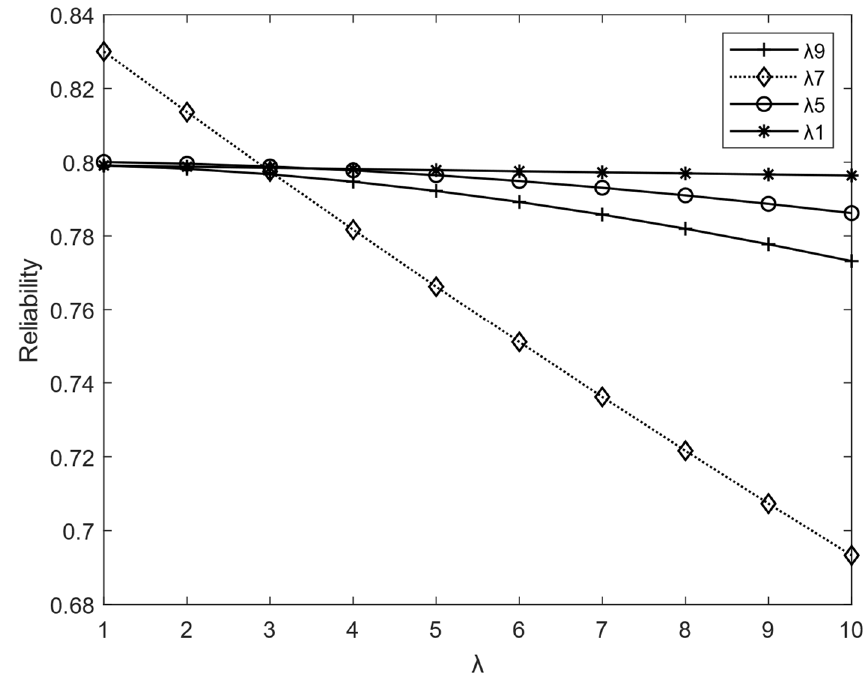
Figure 6. Service life changes with reliability.